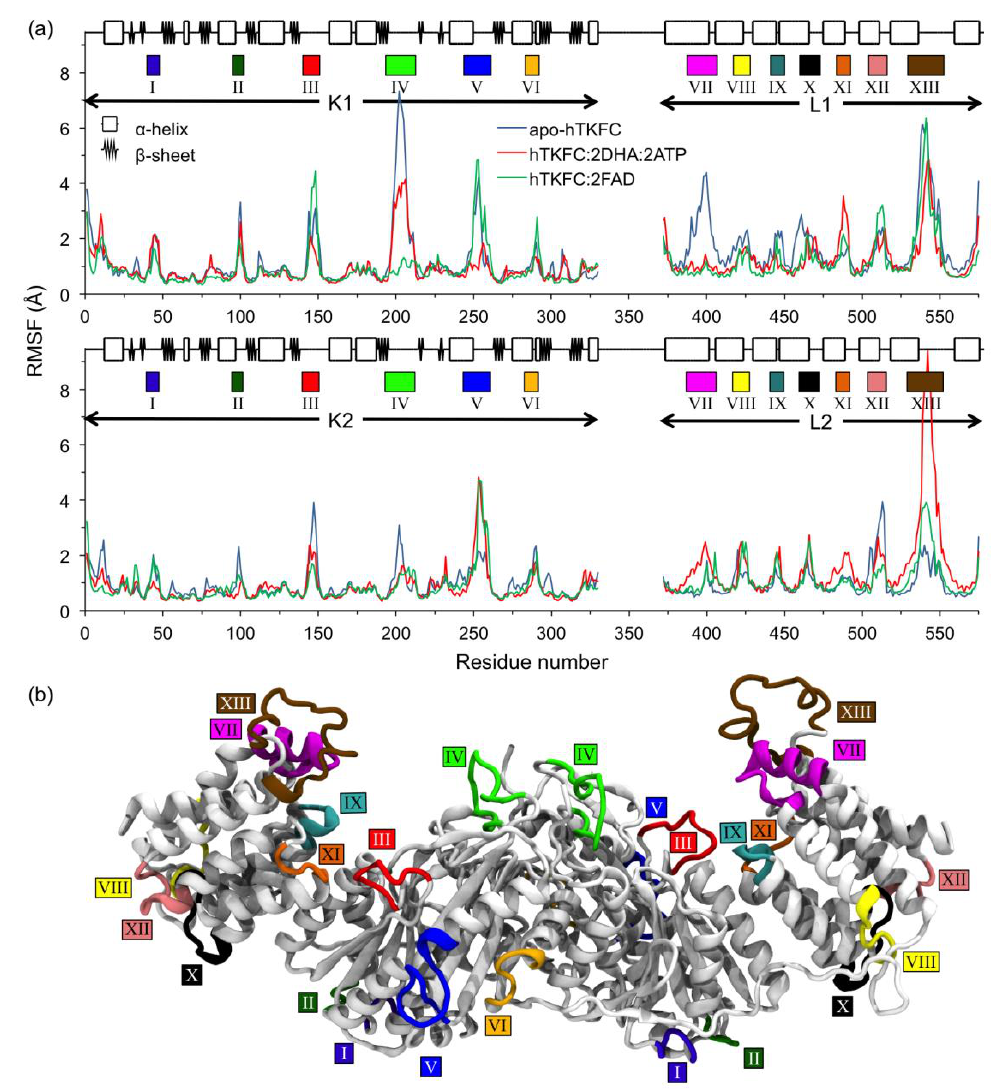
Figure 7. Distribution of mobility in the peptide chains of the hTKFC systems. ( a ) Root-mean square fluctuations (RMSF) of C α atom positions relative to their mean positions during the 20–120-ns molecular dynamics simulations. Data for subunits 1 and 2 are in separate panels. ( b ) Location of the regions with higher fluctuation in the structural model of apo-hTKFC before the dynamics. The colored rectangles below the secondary structure schemes in ( a ) and those in ( b ) mark these regions in the two peptide chains. Only one region VI is visible in part ( b ).